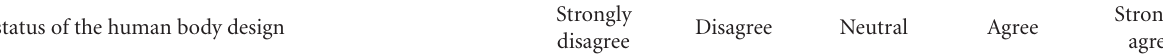
Table 3: Students’ perspectives on the status of the human body’s design.